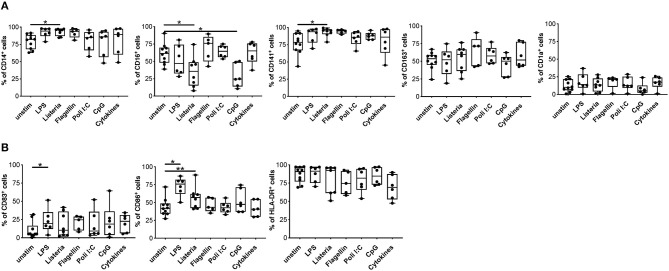
Upon activation, DCIL−10 maintain their phenotype. At the end of differentiation, DCIL−10 were activated with LPS, Heat Killed Listeria Monocytogenes, Flagellin S. typhimurium, Poli I:C, ODN2006 (CpG), or a mix of cytokines (IL-1β, TNF-α, and IL-6). After 24 h, the expression of the indicated markers was evaluated by flow cytometry. (A) Markers associated with DC-10 differentiation (CD14, CD16, CD163, CD141 CD1a); (B) HLA class II (HLA-DR), and co-stimulatory (CD83 and CD86) molecules (n = 5–10). Each dot represents a single donor, lines indicate median, while whiskers are minimum and maximum levels. *P ≤ 0.05, **P ≤ 0.01 (Wilcoxon matched pairs test, two-tailed).